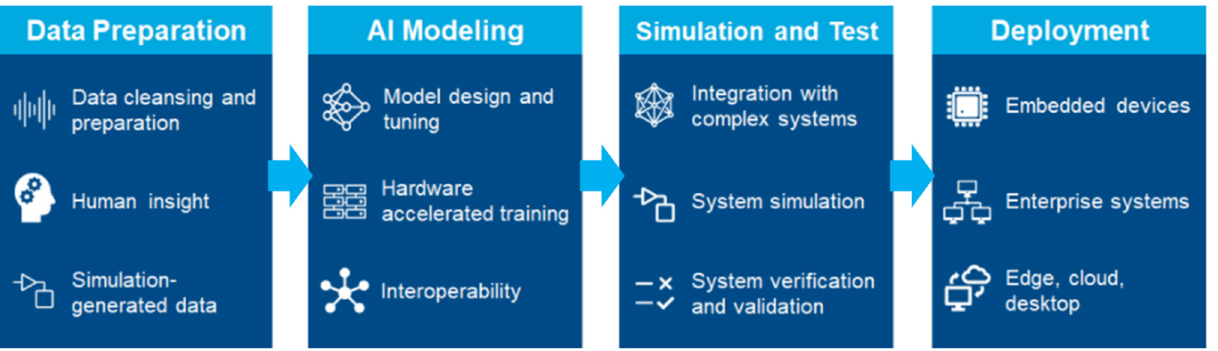
Figure 3. Workflow of AI-based project development in MATLAB.